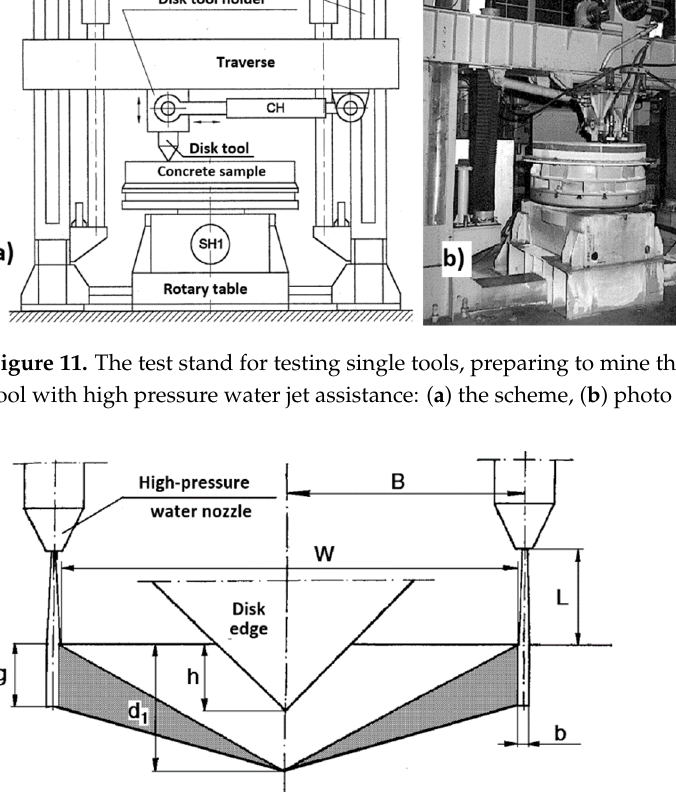
Figure 12. The diagram of mining by means of a symmetrical disk tool with assistance of HPW jets located on the sides of the disk tool [1]. Figure 13. The diagram of a cross-section of the cut obtained by mining with a symmetrical disk tool assisted by two HPW jets located on the sides of the disk tool [1].